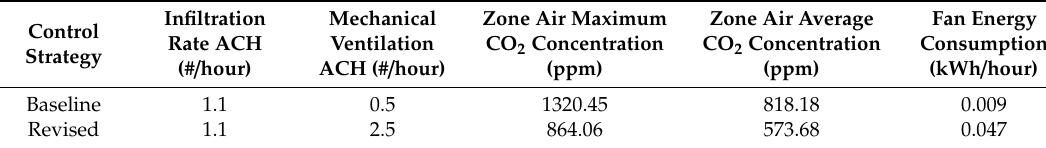
Table 7. Reduction in Carbon Dioxide Concentration.